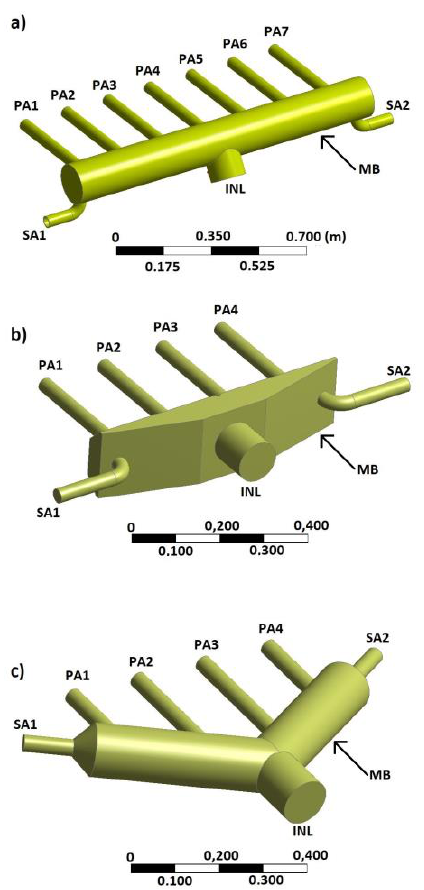
Fig. 1. Successive designs of air manifolds developed by the manufacturer and the authors of this paper